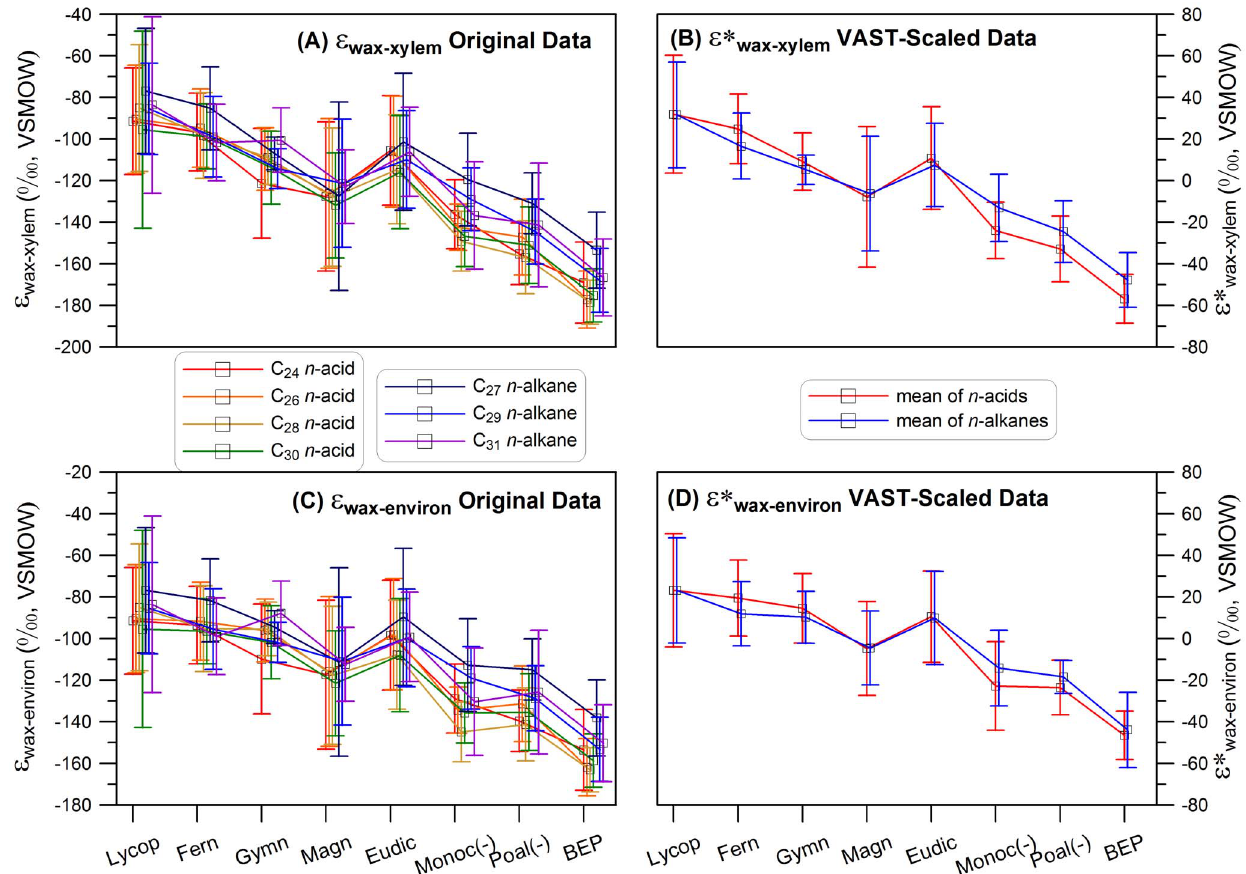
Figure 1. Leaf wax hydrogen isotope fractionation relative to environmental water ( e wax-environ. ) and xylem water (stem water, e wax-xylem ) for all major lineages of terrestrial vascular plants. Lycop = Lycopod; Gymn = Gymnosperm; Magn = Magnoliids; Eudic = Eudicots; Monoc(-) = Monocots excluding Poales; and Poal(-).= Poales excluding BHP; BEP comprises subfamilies Bambusoideae, Ehrhartoideae and Pooideae within the graminoids. The error bars show the 1 s standard deviation for all the species in individual lineages. A and C are for original data of e wax-environ. and e wax-xylem values. B and D are the scaled and averaged data for the two sets of values ( e * wax-environ. and e * wax-xylem ), respectively. See supplementary information on the rationale and methods for scaling the isotopic measurements.